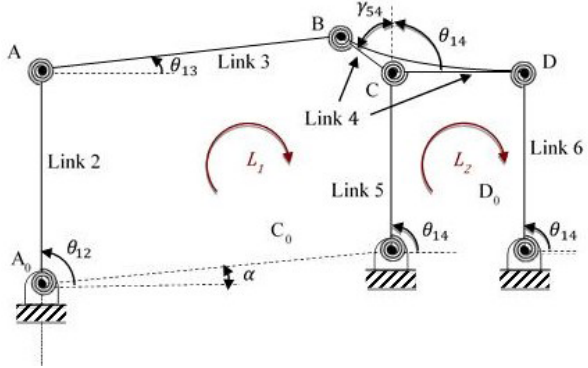
Figure 3. Structure parameters and variables for the kinematic anal-